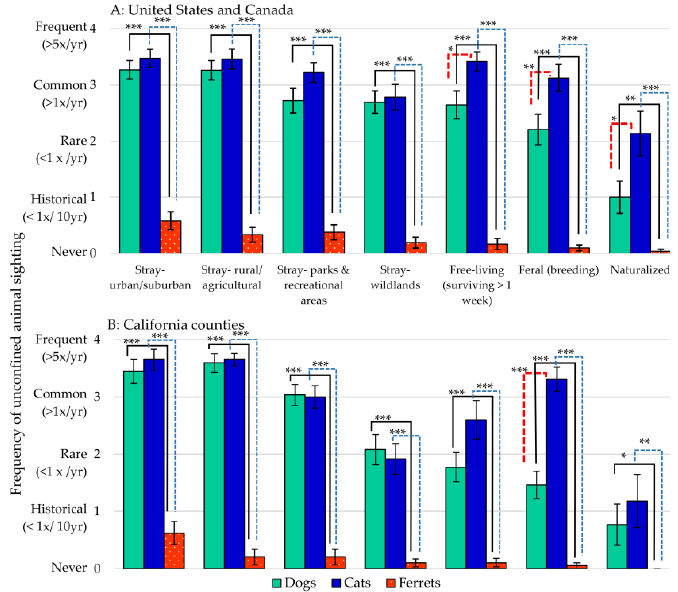
Figure 1. Frequency of sighting for unconfined dogs, cats, and ferrets for: ( A ) United States, and Canada ( B ) California counties. Rating mean ± standard error of the mean (sem). Asterisk represents significant difference; * p < 0.05, ** p < 0.01, *** p <